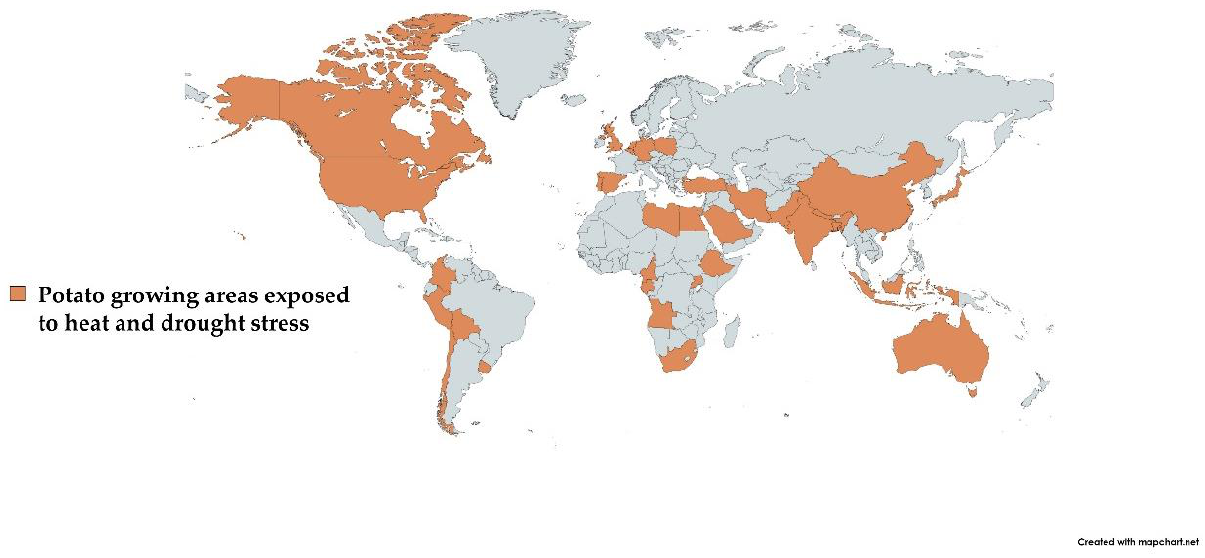
Figure 1. The area shown in brown color depicts the major potato-growing areas affected due to heat and drought stress.